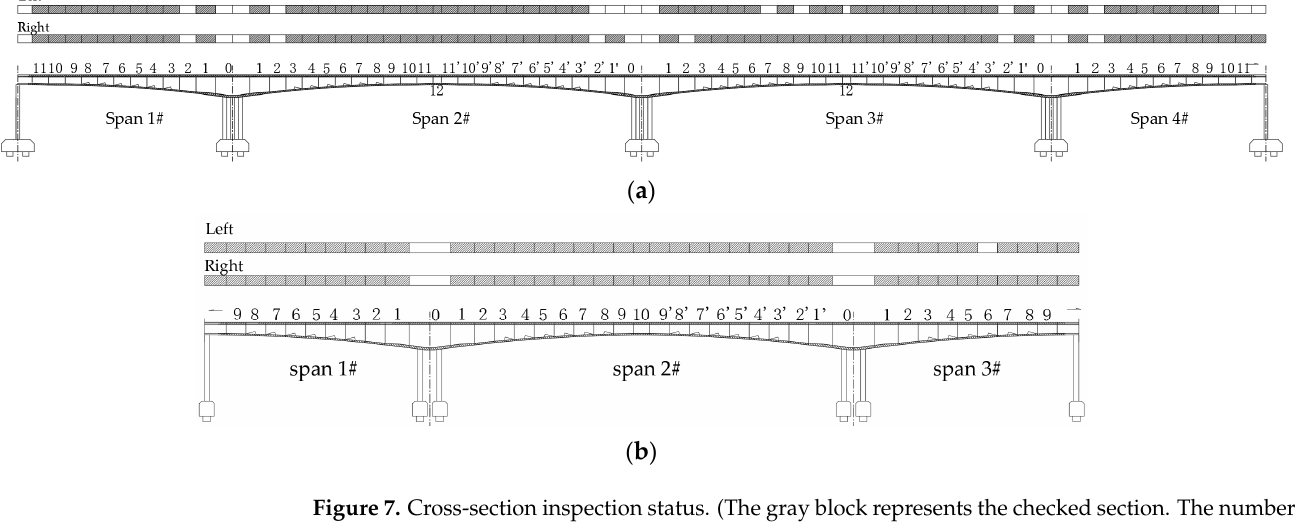
Table 3. Notations of sectional dimension and measurement position.